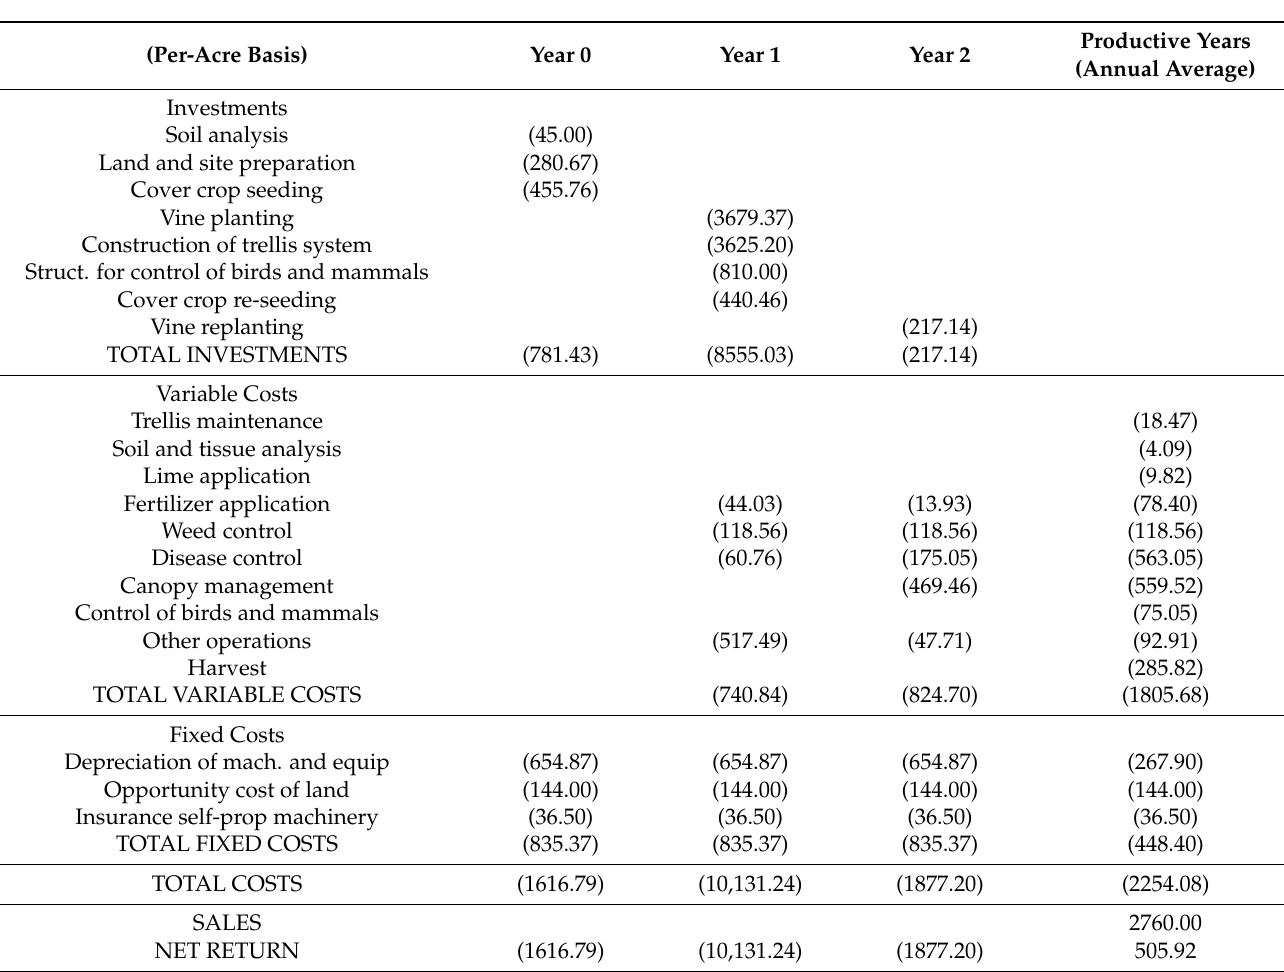
Table 4. Summary of budget items for a 10-acre Marquette vineyard. Productive years from year 4